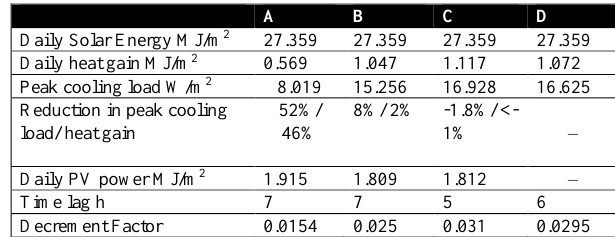
Fig. 11. Radiation interactions of surface exposed to